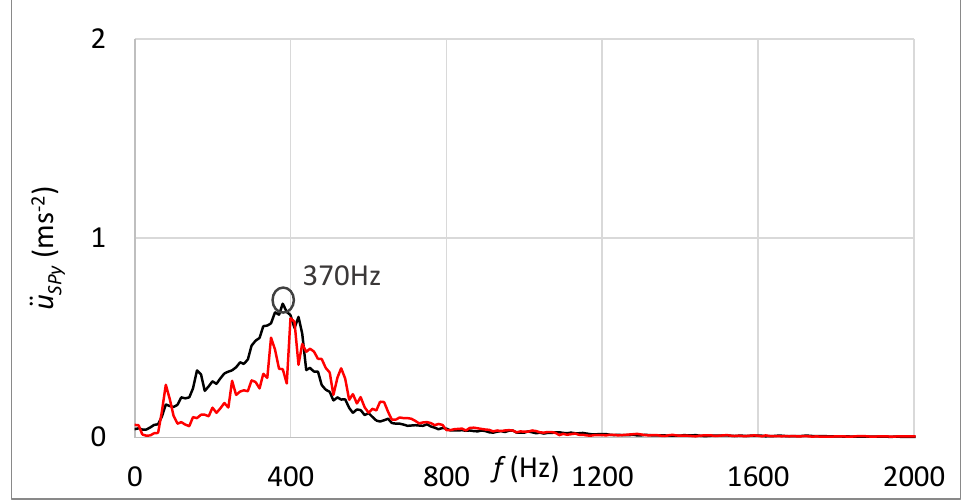
Figure 25. Frequency spectrum of vibrations with the sensor connection by the rubber spring and additional weight; black—the damage of rolling elements; red—without the damage.